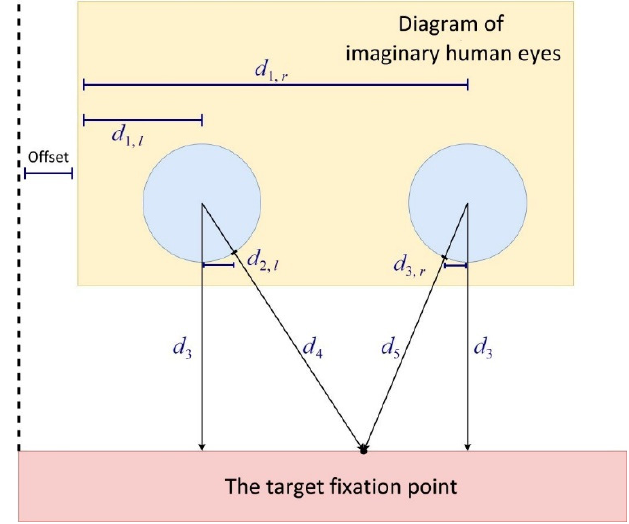
Figure 14. Geometry relationship of the target fixation point for eye gazing.